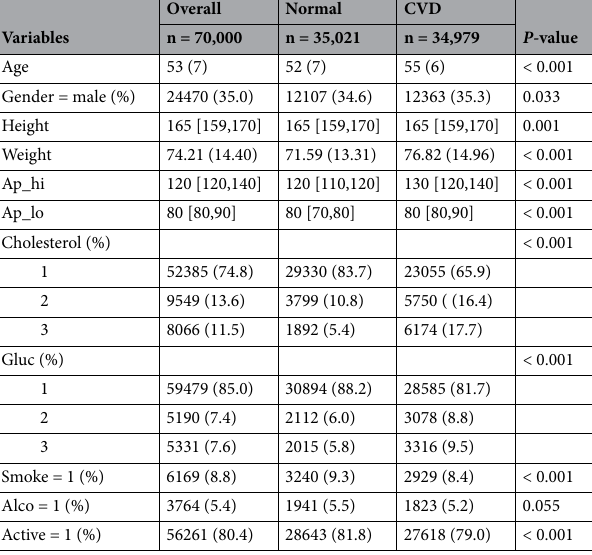
Table 1. Baseline characteristics of